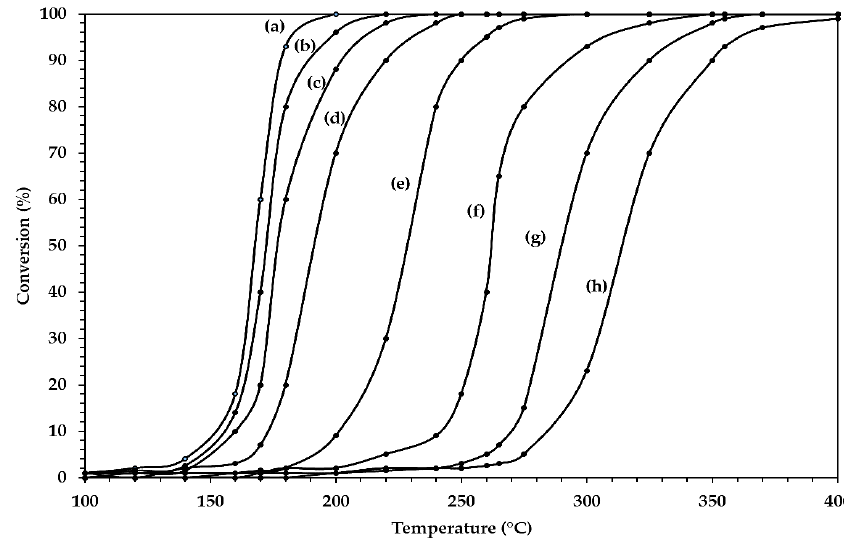
Figure 14. CO conversion of Pt25SA–WO x catalysts reduced to 800 ◦ C: ( a ) Pt100A-(reduced to 500 ◦ C), ( b ) Pt25SA–0.5W, ( c ) Pt25SA–1W, ( d ) Pt100A catalyst (reduced at 800 ◦ C), ( e ) Pt25SA–2W, ( f ) Pt25SA–4W ( g ), Pt25SA–8W, and ( h ) the 25SA support. Table 5. CO combustion temperatures at conversions of 50% (T 50 ) and 90% (T 90 ) for catalysts pre- pared: Monometalic Pt reduced at 500 °C (Pt100A-(500)) and 800 °C (Pt100A-(800)), bimetallic Pt-W (Pt25SA‒0.5W to Pt25SA‒8W), and the support 25SA. Catalyst T50 (°C) Pt100A-(500)